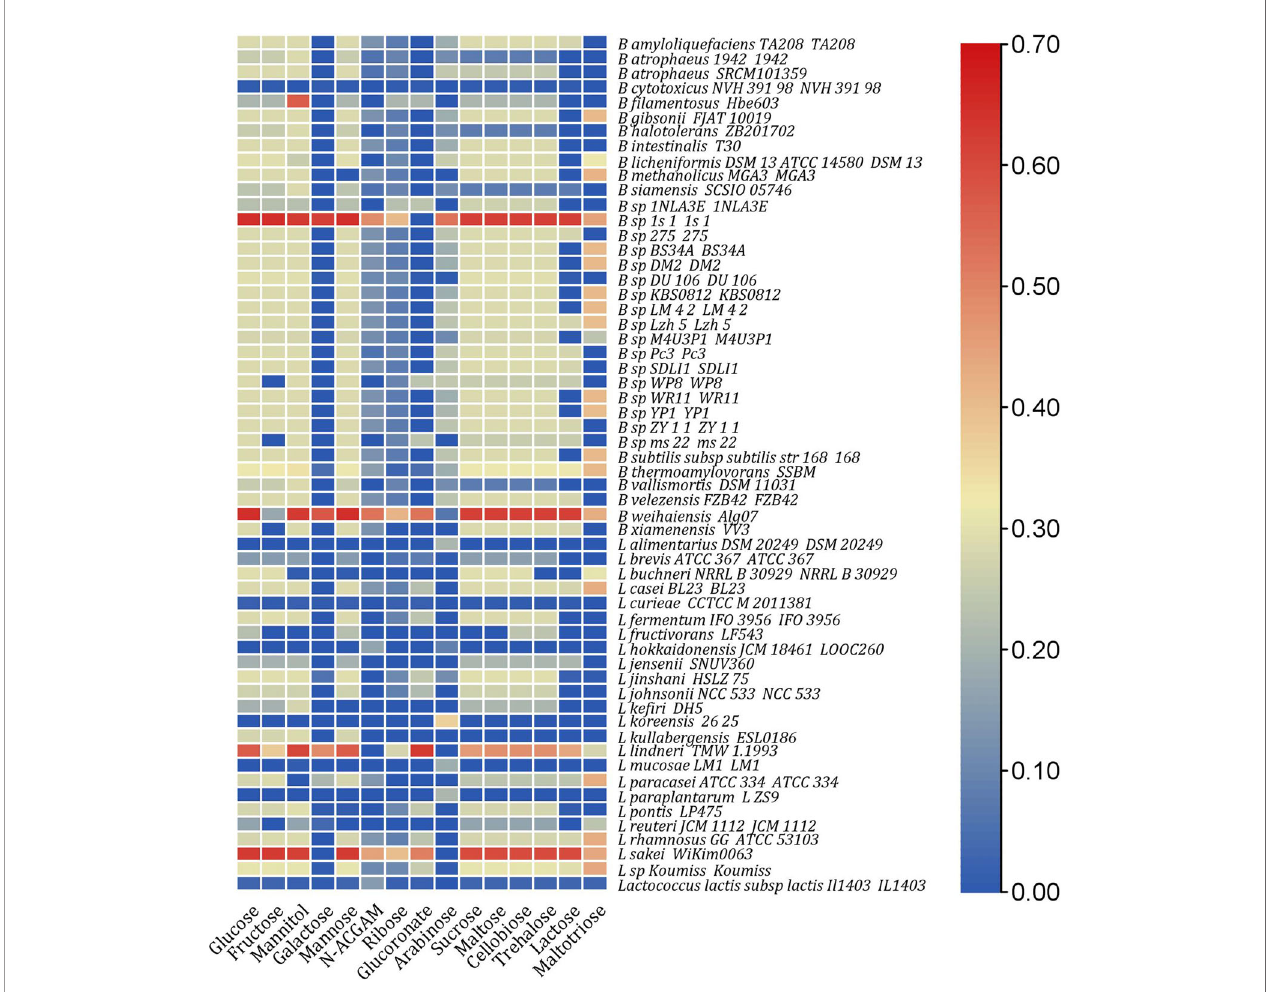
FIGURE 1 | Heat map representing computed growth rates of strains with signi fi cant increase in growth rates (at least 10% uplift in in silico growth rate than single species) in a paired community with 15 different nutrient